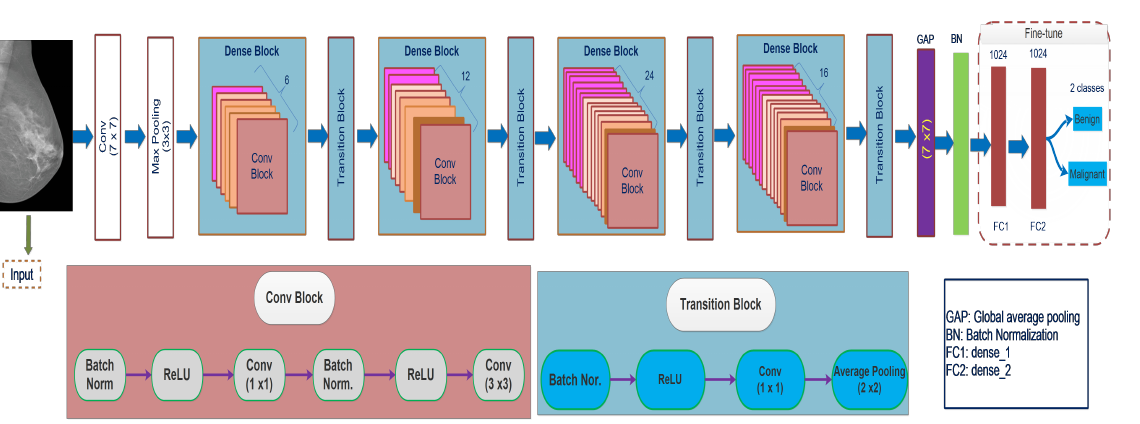
Figure 5. Representation of the network structure of the DenseNet121